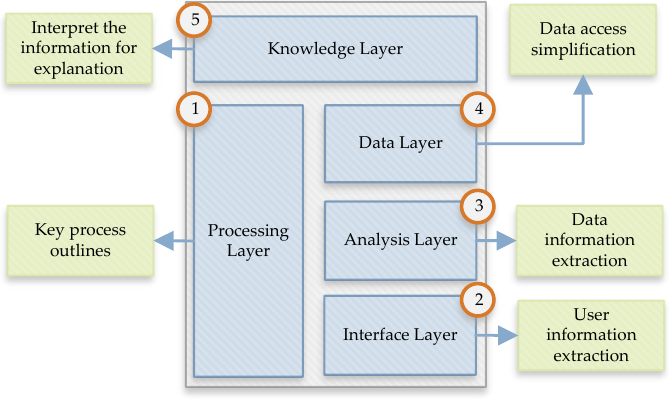
Figure 4. Multi-layered data processing.